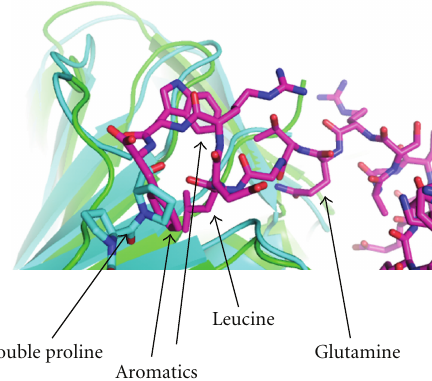
Figure 8: Comparison of the binding pockets of SsoPCNA 1 and 2. The PCNA2 subunit (blue) is superimposed on the PCNA1 subunit of 2IZO (green) to demonstrate that the typical binding motif of Fen1 (magenta, stick representation) cannot be accommodated within the binding pocket of PCNA2 due to steric hindrance [9]. The double proline motif of PCNA2 responsible for the blocking shift in the IDCL is